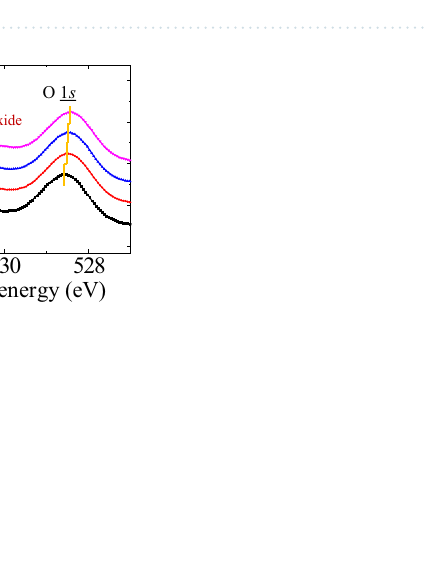
Figure 6. High-angle annular dark-field (HAADF) image of a La 1.85 Sr 0.15 CuO 4 thin film. ( a ) A large area image of the film and substrate. ( b ) High-resolution image of the interfacial area between the thin film and the substrate. ( c ) The epitaxial relation between film and substrate at the interface. It can be also clearly seen that the thin film has a layered perovskite structure.